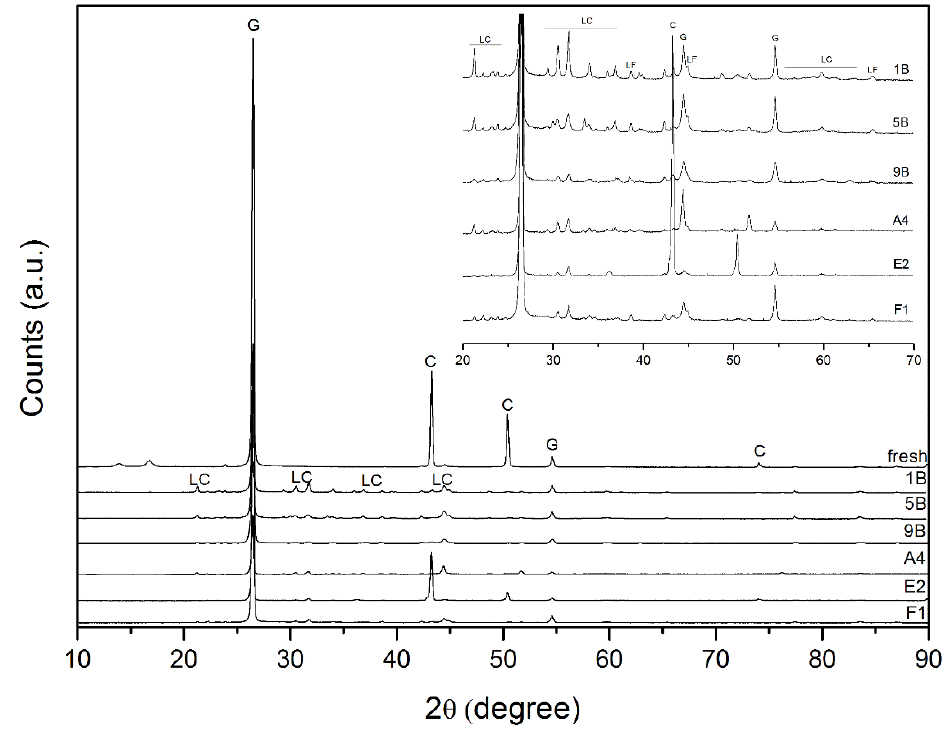
Figure 9. XRD spectra of anode before (new) and after thermal abuse tests (1B, 5B, 9B, A4, E2, F1) with relative zoom. (C = Cu, G = graphite, LC = Li 2 CO 3 , LF = LiF).